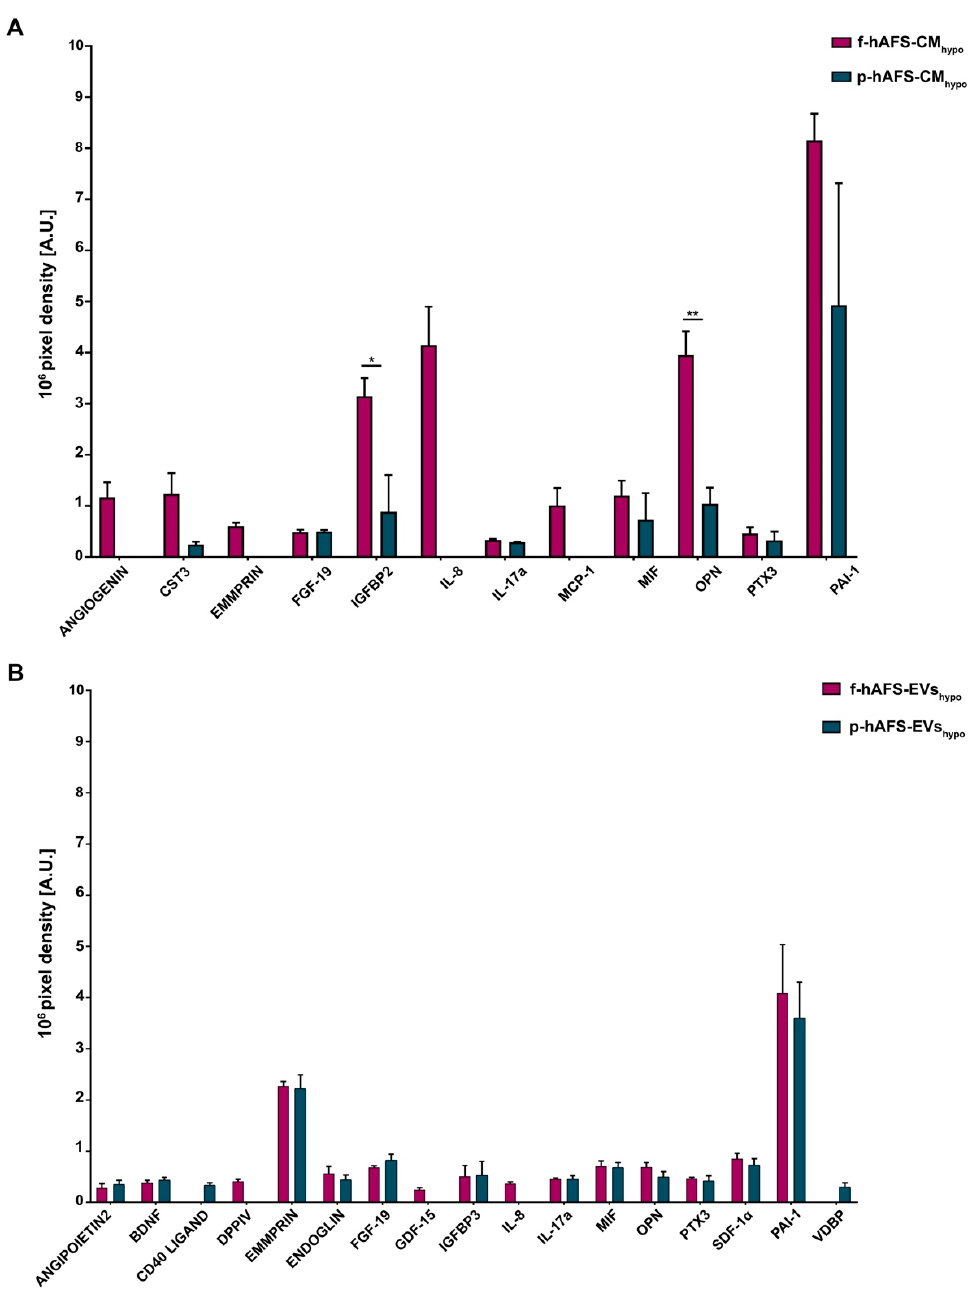
Figure 7. Cytokine and chemokine profiling within fetal- and perinatal hAFS secretome formulations. ( A ) Expression of cytokines and chemokines detected within the hypoxic fetal- versus perinatal hAFS-CM (f-hAFS-CM hypo vs p-hAFS-CM hypo ) are reported in pixel density by arbitrary unit [A.U.]. Values are expressed as mean ± s.e.m of n = 3 independent experiments and reported in Table S4; * p = 0.0485; ** p = 0.006. ( B ) Cytokine and chemokine content detected in the hypoxic fetal- versus perinatal hAFS-EVs (f-hAFS-EVs hypo vs p-hAFS-EVs hypo ) and expressed by pixel density in arbitrary units [A.U.]. Values are expressed as mean ± s.e.m of n = 3 independent experiments and reported in Table S5. CST3 : Cystatin C ; EMMPRIN : Extracellular Matrix MetalloPRoteinase Inducer ; FGF-19 : Fibroblast Growth Factor-19 ; IGFBP2 : Insulin-like Growth Factor (IGF) Binding Protein 2 ; IL-8 : Interleukin-8 ; IL-17a : Interleukin-17a ; MCP-1 : Monocyte Chemoattractant Protein-1 ; MIF : Macrophage migration Inhibitory Factor ; PTX3 : Pentraxin 3 ; PAI-1 : Plasminogen Activator Inhibitor-1 ; BDNF : Brain-Derived Neurotrophic Factor ; DPPIV : DiPeptidyl Peptidase IV ; GDF-15 : Growth Differentiation Factor-15 ; IGFBP3 : Insulin-like Growth Factor (IGF) Binding Protein 3 ; SDF-1 α : Stromal Derived Factor-1 alpha ; VDBP : Vitamin D-Binding Protein .